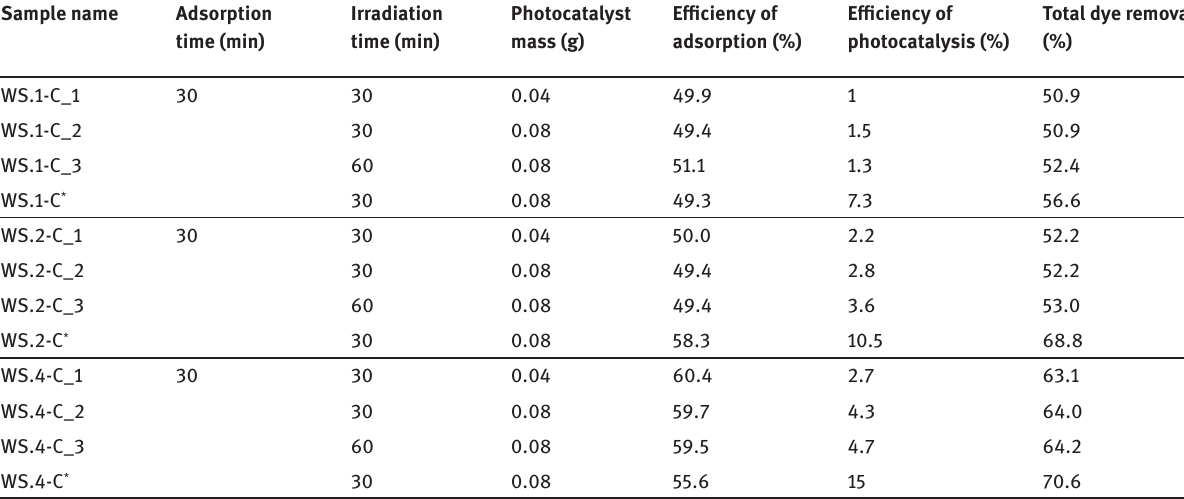
Table 5: Results of photocatalytic and adsorption